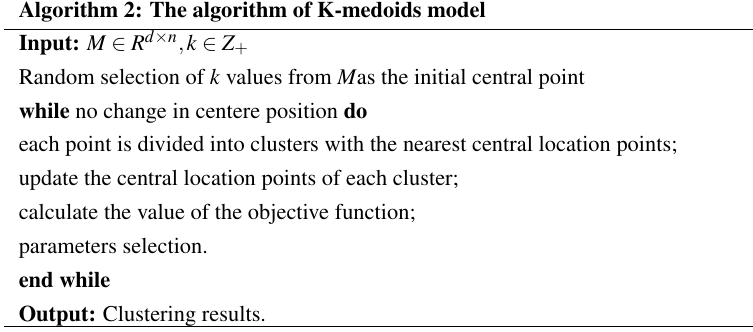
Algorithm 2: The algorithm of K-medoids model